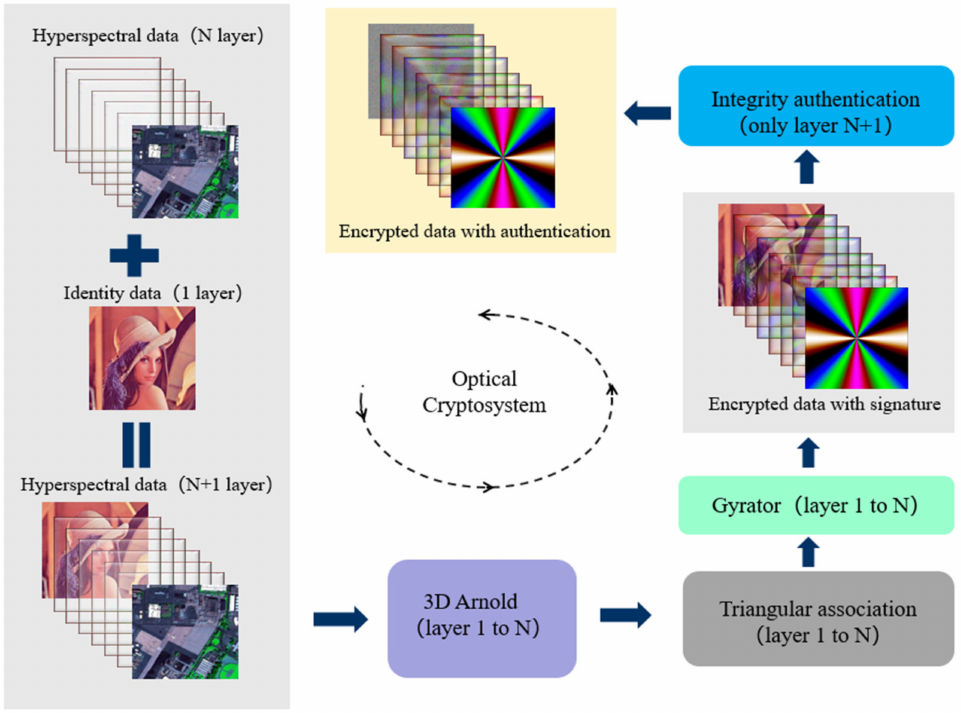
Figure 1. The flowchart of the hyperspectral image encryption